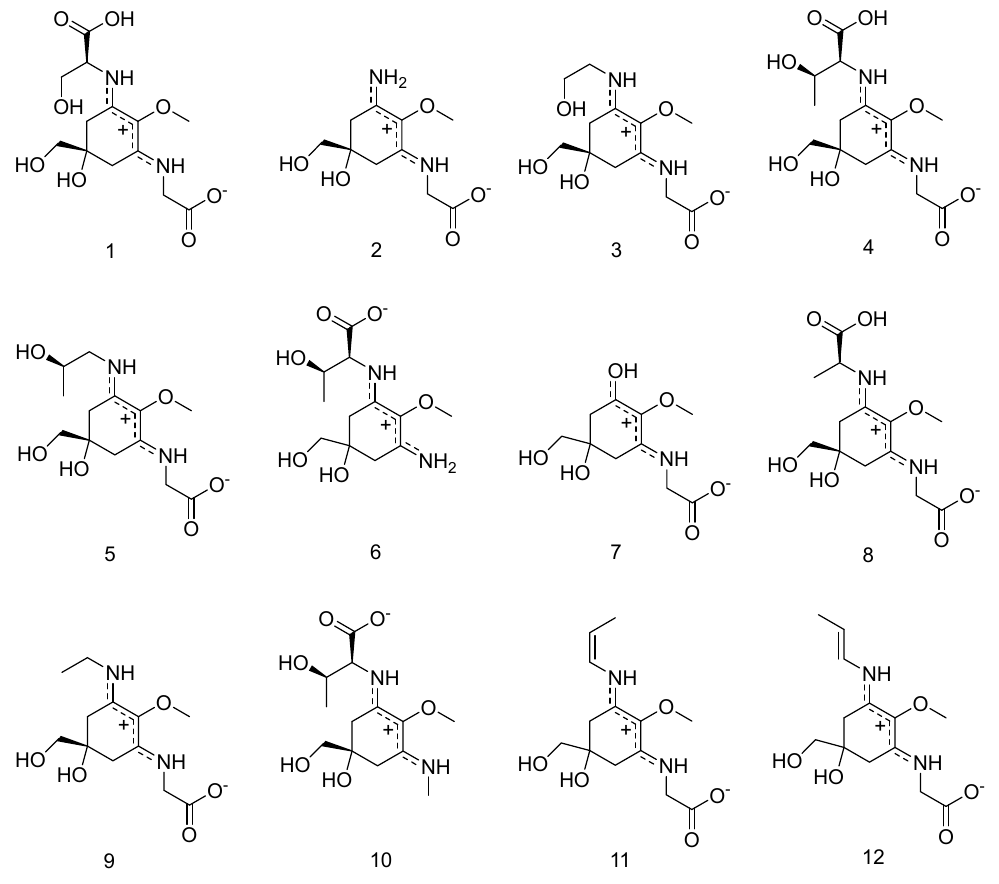
Figure 1. The structures of compounds 1 – 12 .